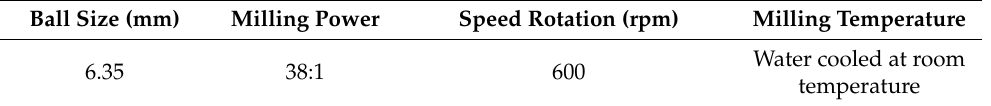
Table 1. Milling Parameters.